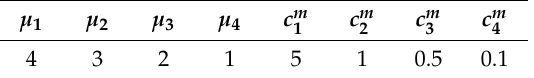
Table A4. Parameters of rolling dispatch model.